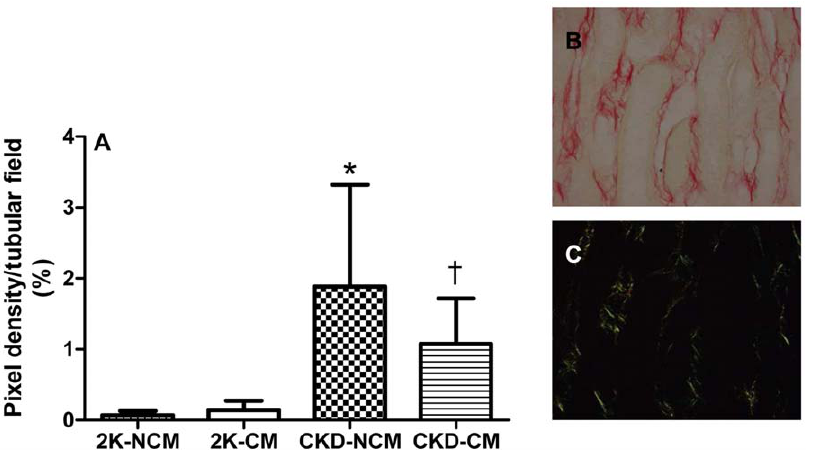
Figure 7. Tubular collagen I and III deposition was reduced after CM treatment in CKD rats. CM treatment reduced sirius red staining (A). Raw (B) and polarized (C) pictures are shown. 2K-NCM (n=6); 2K-CM (n=6); CKD-NCM (n=13); CKD-CM (n=13). *P , 0.05: CKD vs. 2K, { P , 0.05: CKD- CM vs. CKD-NCM.